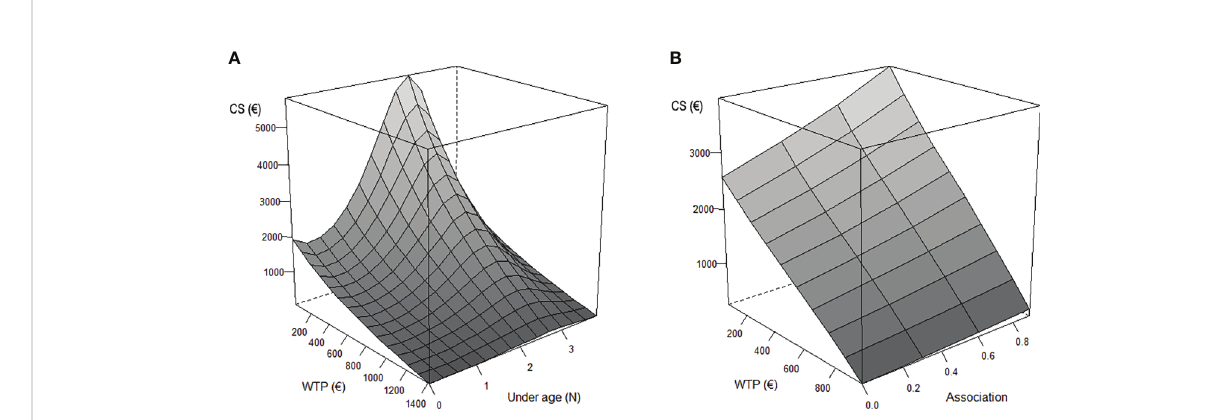
FIGURE 6 Consumer surplus (CS) per person and year estimated from fi shing charter boat trips to Spain (Galicia; A ) and Portugal (Madeira archipelago; B ) by bidimensional GAMs. The covariate Willingness To Pay (WTP) was a function of the full individual travel cost. In the case of Galicia, the other covariate was the number of underage people in the household, while in Madeira we used a dummy numeric variable to include the membership (1) or not (0) to a recreational fi shing association (see in Table 4 the outputs of the GAMs fi tted on the fi shing